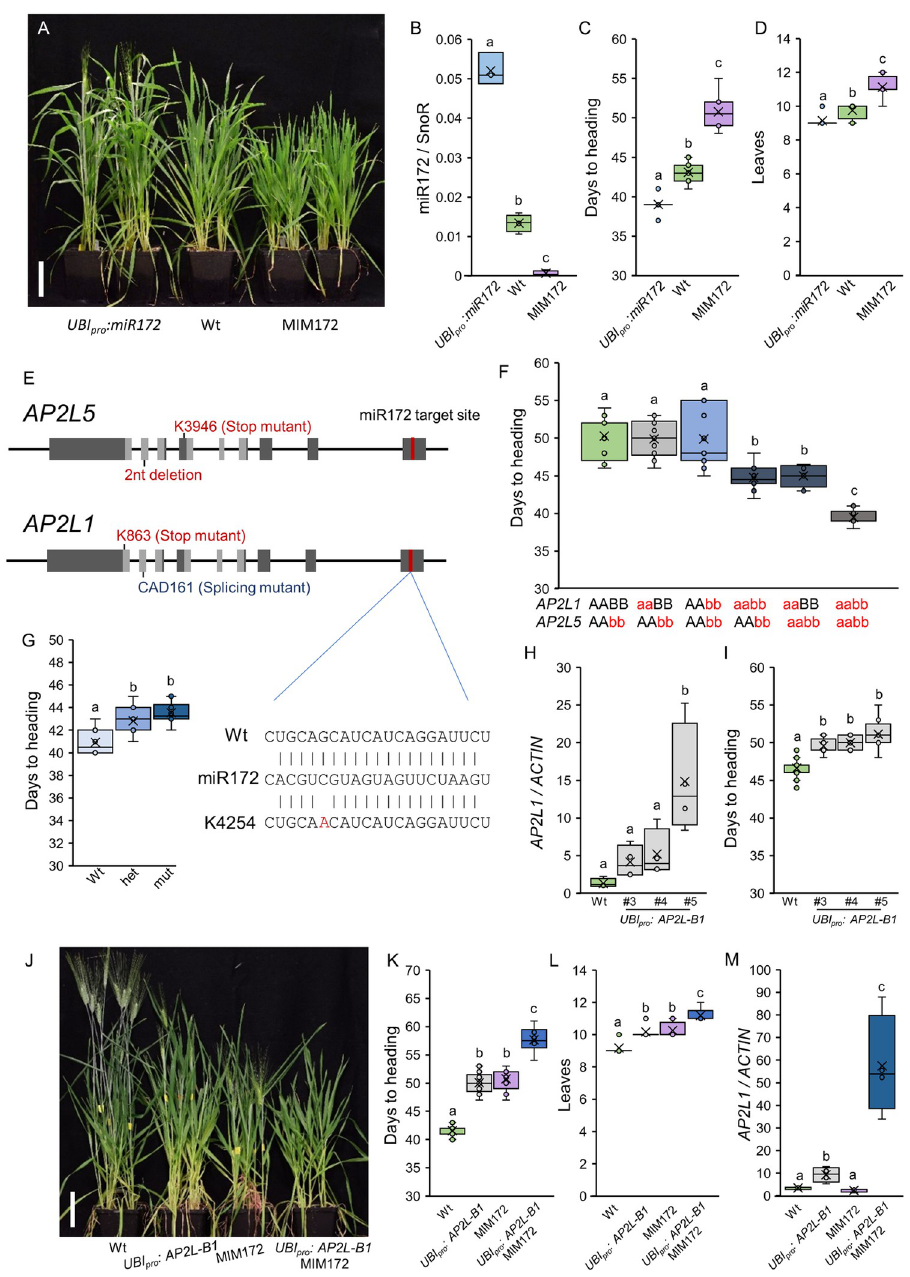
Fig 1. miR172 promotes flowering in wheat by repressing AP2L genes. ( A ) Six-week-old wild type Kronos plants (Wt) compared to UBI : miR172 and MIM172 transgenic plants in the same genetic background grown under LD. pro Scale bar = 10 cm. ( B ) Box plots showing miR172 expression levels in the 5 th leaf of UBI pro : miR172 , wild type Kronos (Wt) and MIM172 plants grown under LD. Mature miR172 levels were determined by qRT-PCR using the small nucleolar RNA 101 (SnoR) as internal reference. Data correspond to four independent biological replicates. ( C-D ) Box plots showing days to heading ( C ; n � 7) and number of leaves produced by the main tiller ( D ; n � 7) in the same genotypes and conditions as in B. ( E ) Schematic diagrams showing the gene structures of AP2L5 and AP2L1 . Exons are indicated as dark grey boxes, AP2 domains are indicated in light grey, and the miR172-target sites in red. The positions of the TILLING mutations K3946 ( AP2L5 ) and K863 ( AP2L1 ) in the A homeologs are indicate above the gene structures, and the natural variant with 2 nucleotides deletion ( AP2L5 ) and CAD161 splicing mutant ( AP2L1 ) in the B homeologs below. ( F ) Box plots showing days to heading under LD conditions for wild type (Wt), plants harboring mutations in only one AP2L1 homeolog (aaBB and AAbb), in both AP2L1 homeologs ( ap2l1- null = aabb), ap2l5 -null mutants, and apl2l1 ap2l5 combined null mutants (n � 8). ( G ) Box plots showing days to heading under